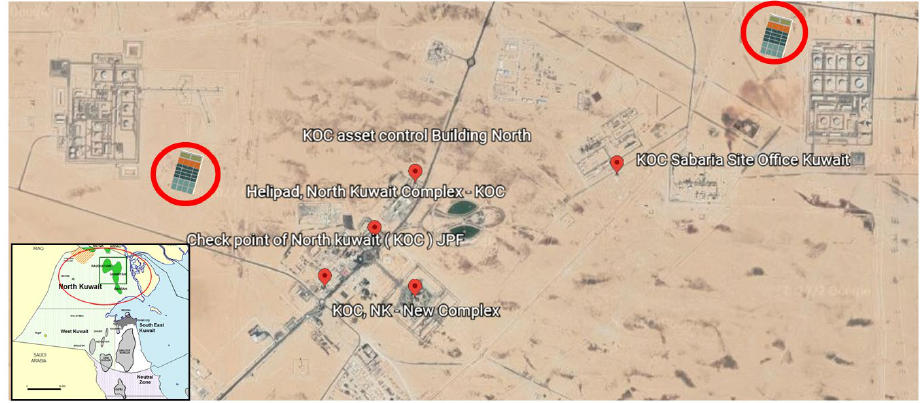
Figure 4. Proposed locations for constructed wetlands.